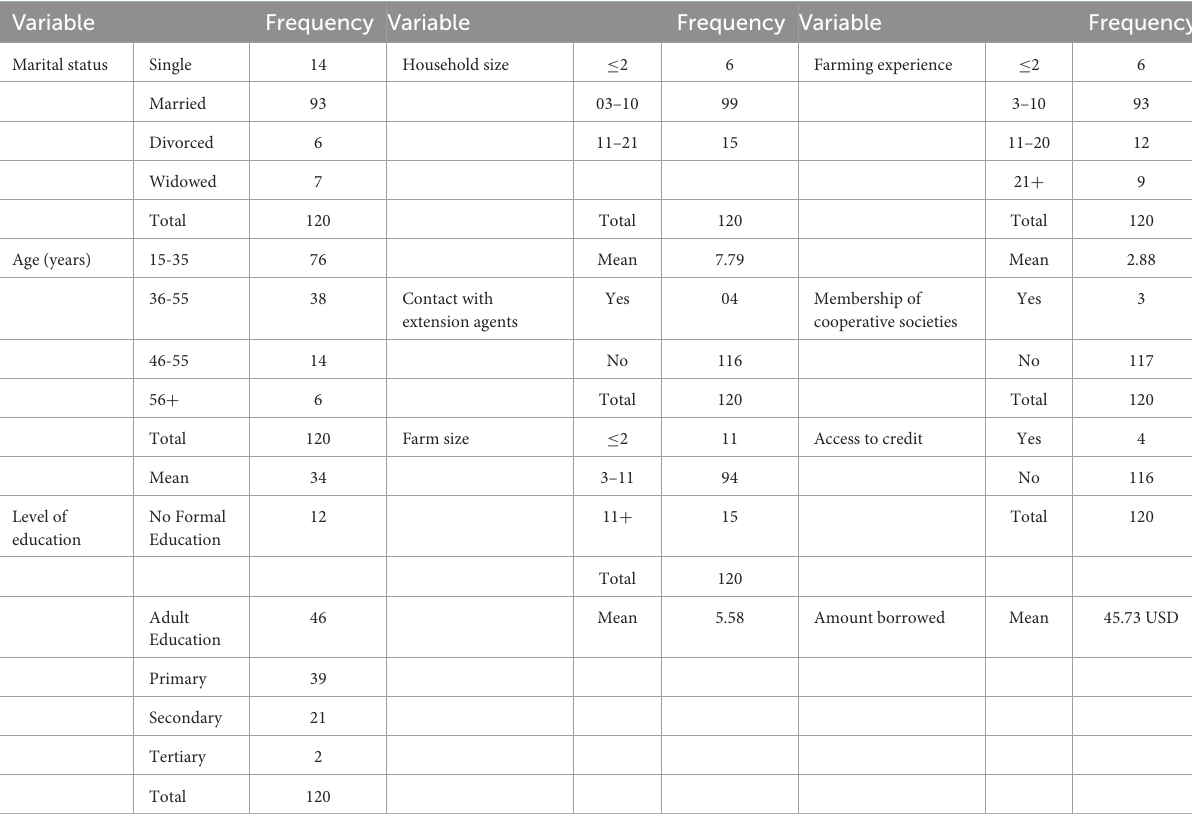
TABLE 2 Distribution of the respondents based on the socio-economic characteristics.